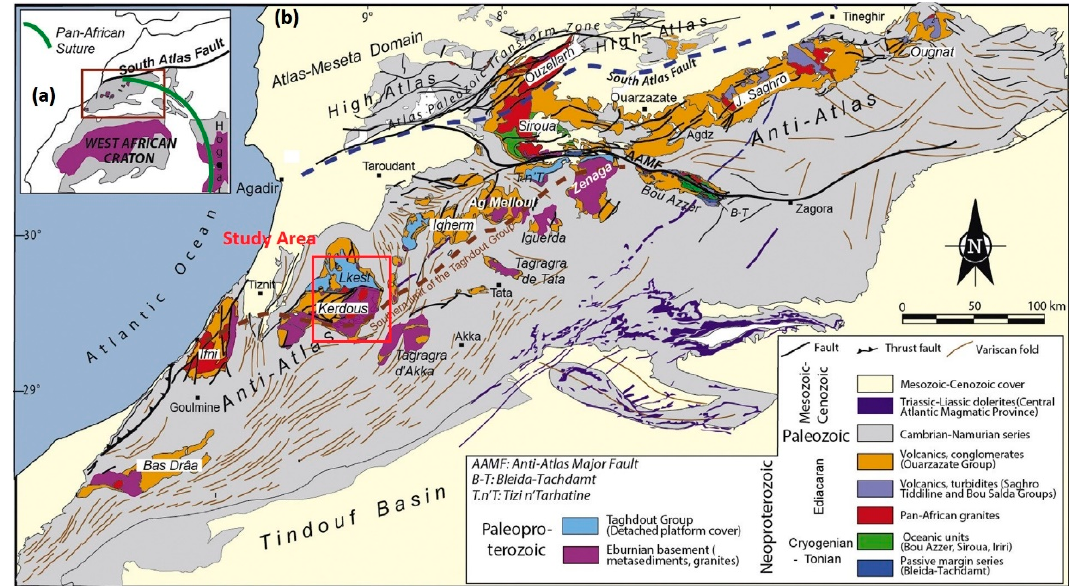
Figure 3. ( a ) The Anti–Atlas belt at the northern boundary of the West African Craton; ( b ) geological map of the Anti–Atlas belt, modified after [60,61].